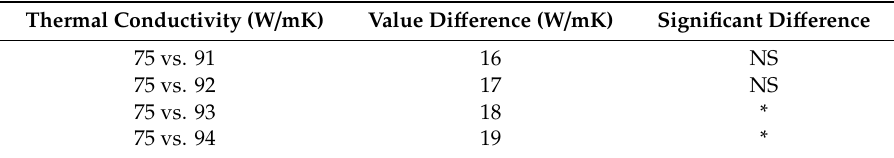
Table 2. Result of threshold experiment by using significant di ff erent